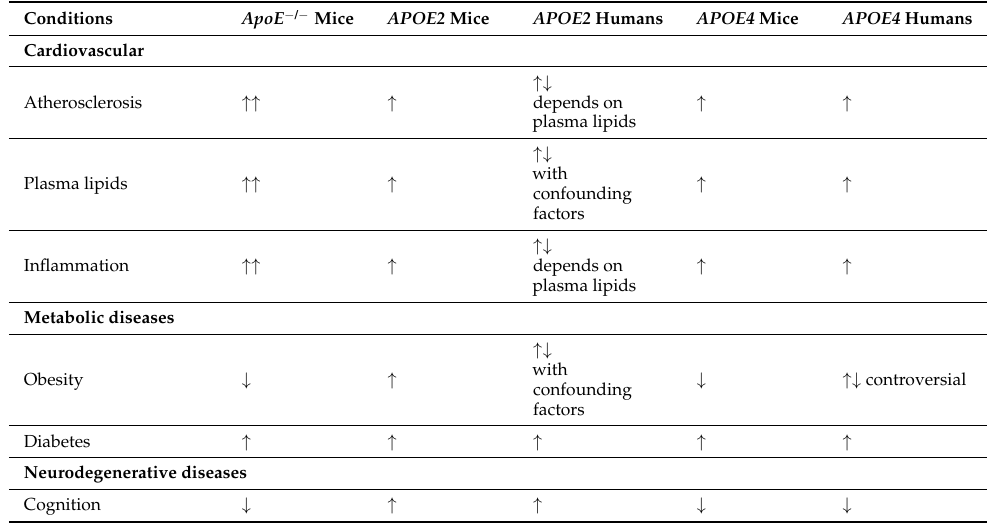
Table 1. Influence of apoE inactivation, apoE2, and apoE4 on cardiometabolic and neurological diseases in mice and